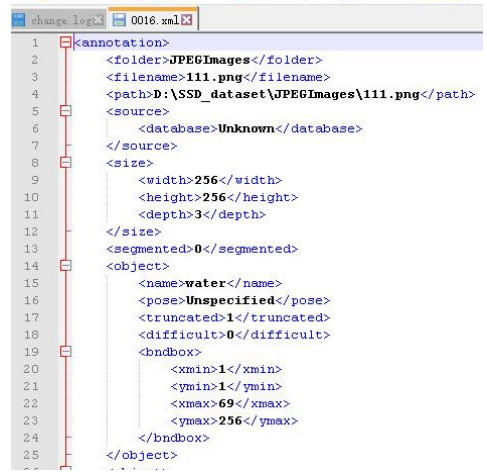
Figure 6. Example of labeling a region.